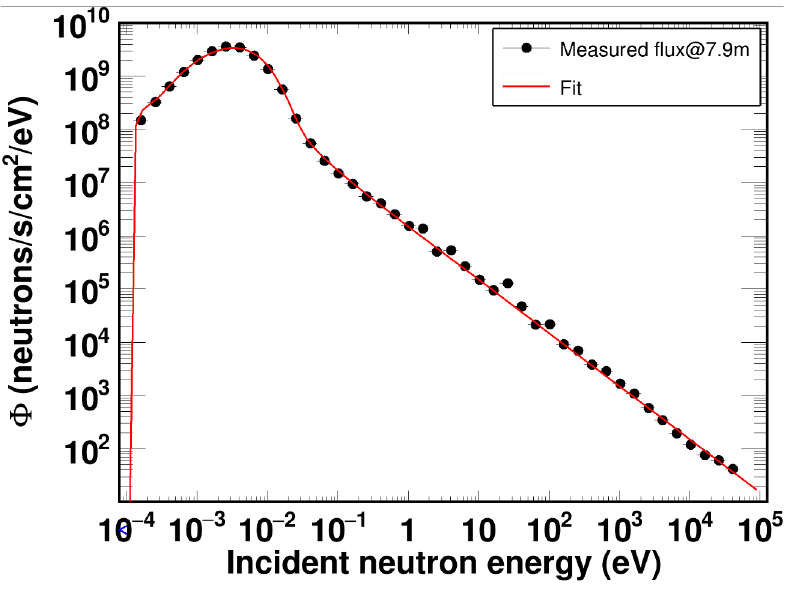
Figure 2. Measured and analytical description of DICER’s neutron spectrum at 7 . 9 m from the spallation